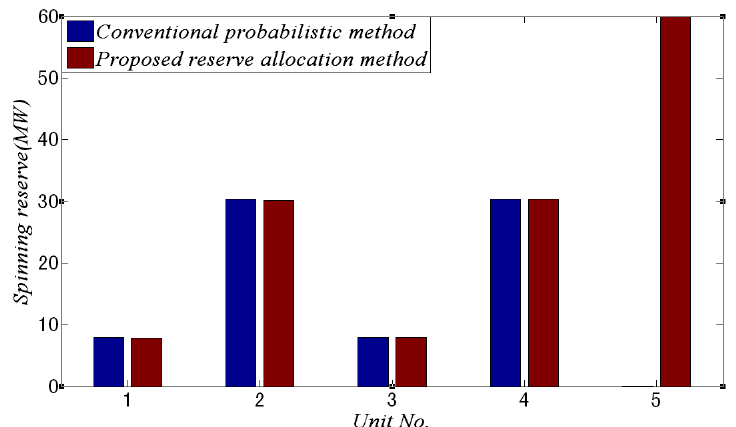
Figure 11. Spinning reserve capacity of the units in sub-area 2.